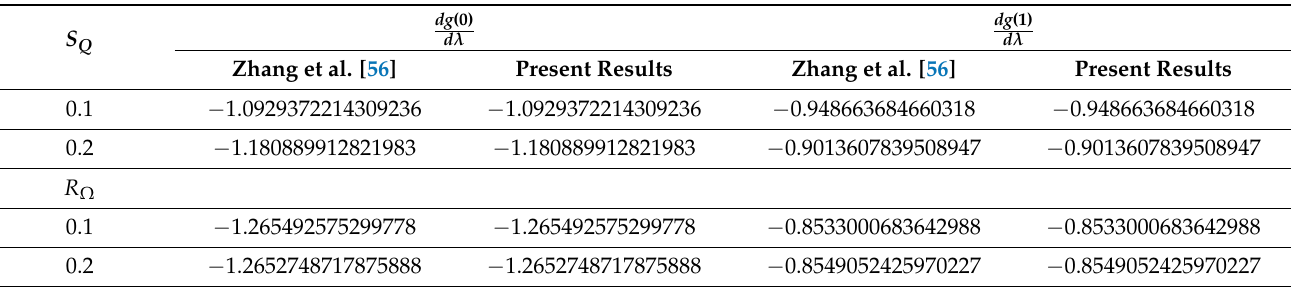
Table 1. Comparison of the torque values at the lower and upper plate with previous results [56] when the fluid behaves as a Newtonian model ( K = 0 ) and the remaining values are R Ω = 0.3, F T = 0.5, Bt = 0.6, K = 0, R d = 0, σ = 0 for various values of S Q and R Ω .